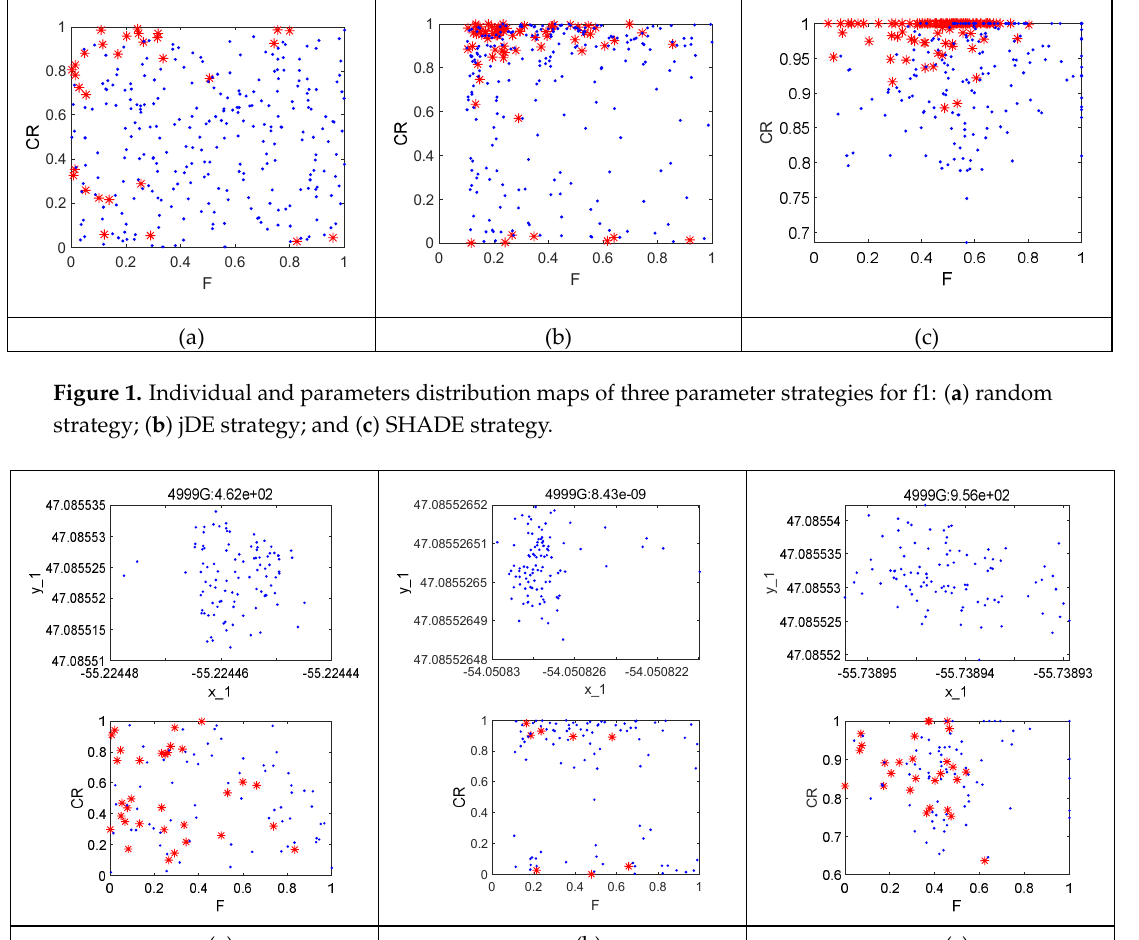
Figure 1. Individual and parameters distribution maps of three parameter strategies for f1: ( a ) random strategy; ( b ) jDE strategy; and ( c ) SHADE strategy.